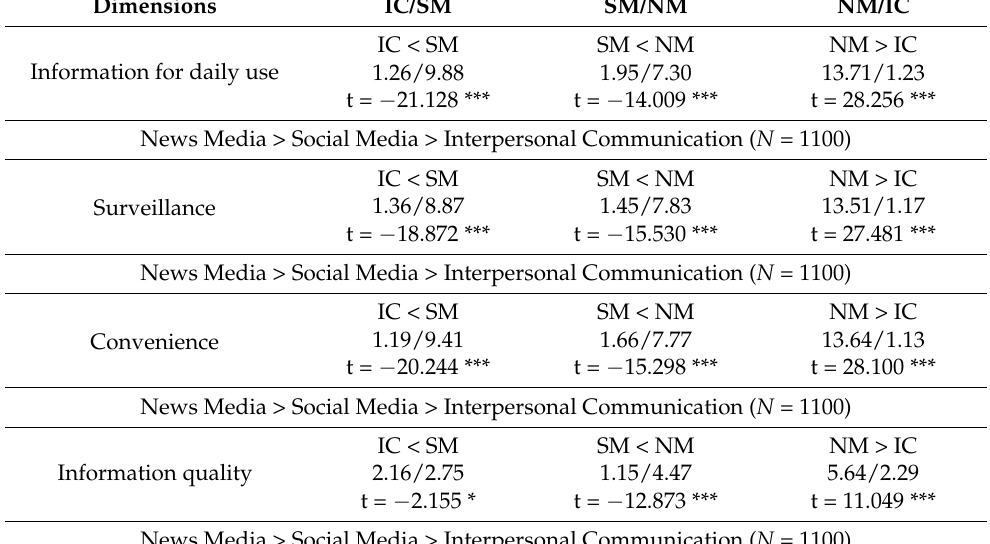
Table 5. Competitive superiority for news media, social media, and interpersonal communication.